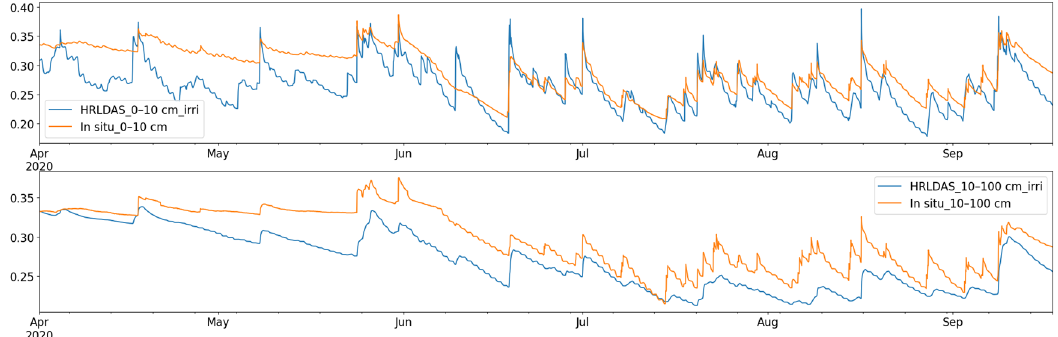
Figure 8. A comparison of HRLDAS SM and ground-observed SM in 2020, averaged over three sites inside Nebraska (from top to bottom: 0–10 cm, 10–100 cm depth).